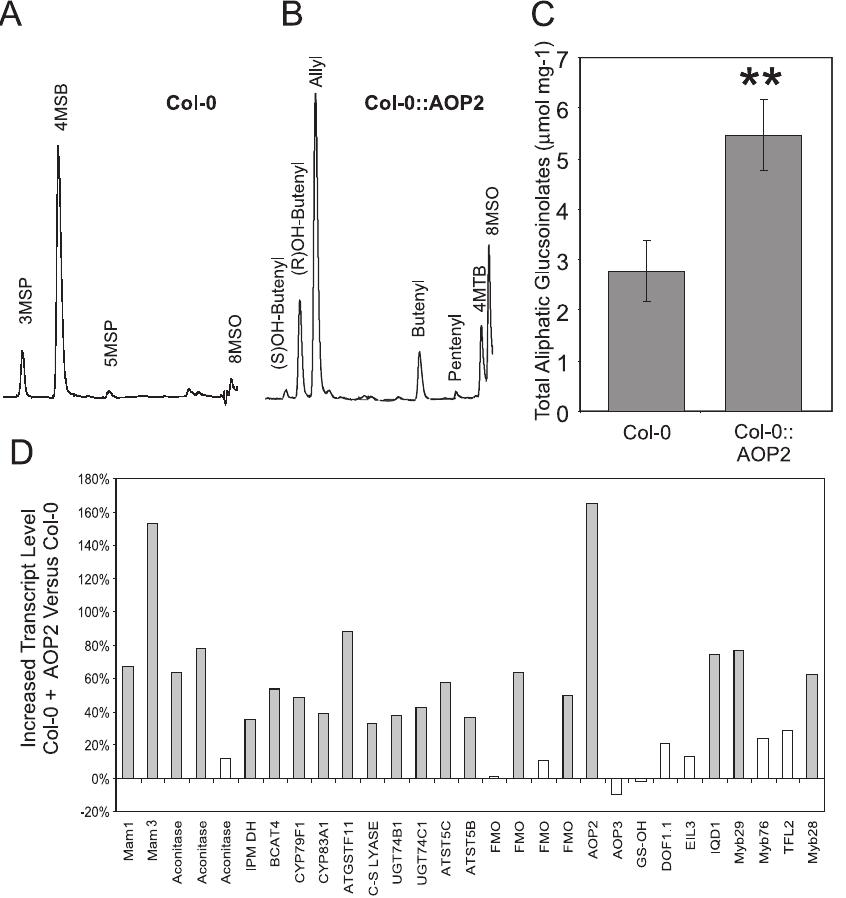
Figure 5. AOP2 Transcript Alters Metabolic Profiles, Content, and Gene Expression Wild-type Col-0 that is null for AOP2 and AOP3 was modified through the introduction of a functional AOP2 transcript from B. oleracea. All glucosinolate abbreviations are as described in Table S1. (A) HPLC profile of aliphatic glucosinolates detected in foliar tissue of wild-type Col-0. (B) HPLC profile of aliphatic glucosinolates detected in foliar tissue of Col-0 containing the functional AOP2 transcript. (C) Average total foliar aliphatic glucosinolate content in Col-0 and Col-0:: AOP2 is shown with standard error bars. Six plants per genotype were measured for total aliphatic glucosinolate content within an experiment, and the experiment was conducted twice to provide 32 total measurements. ** p , 0.0001 as determined by ANOVA. (D) Percentage increase in transcript levels in Col-0:: AOP2 as compared with Col-0 is presented. RNA from 3 plants per genotype were individually hybridized to ATH1 Affymetrix arrays to obtain transcript levels for the aliphatic glucosinolate genes. ANOVA was used to test for significant differences between the two genotypes for the glucosinolate biosynthetic and regulatory genes via ANOVA with a false discovery rate of 0.05. Gray bars show transcripts significantly increased by the introduction of the AOP2 transcript. Nonsignificant changes are shown in white bars.